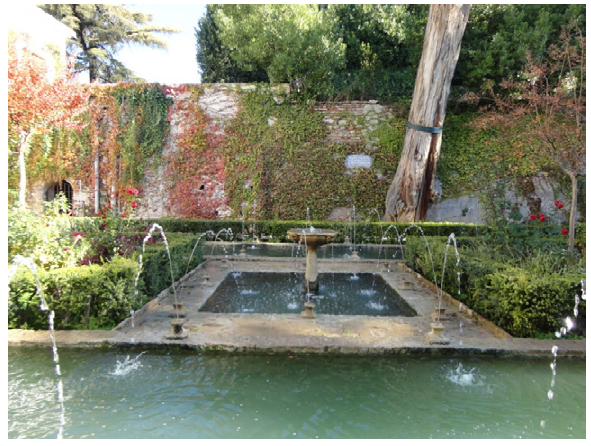
Figure 5. Water pool in Alhambra (photo by the author of the article)